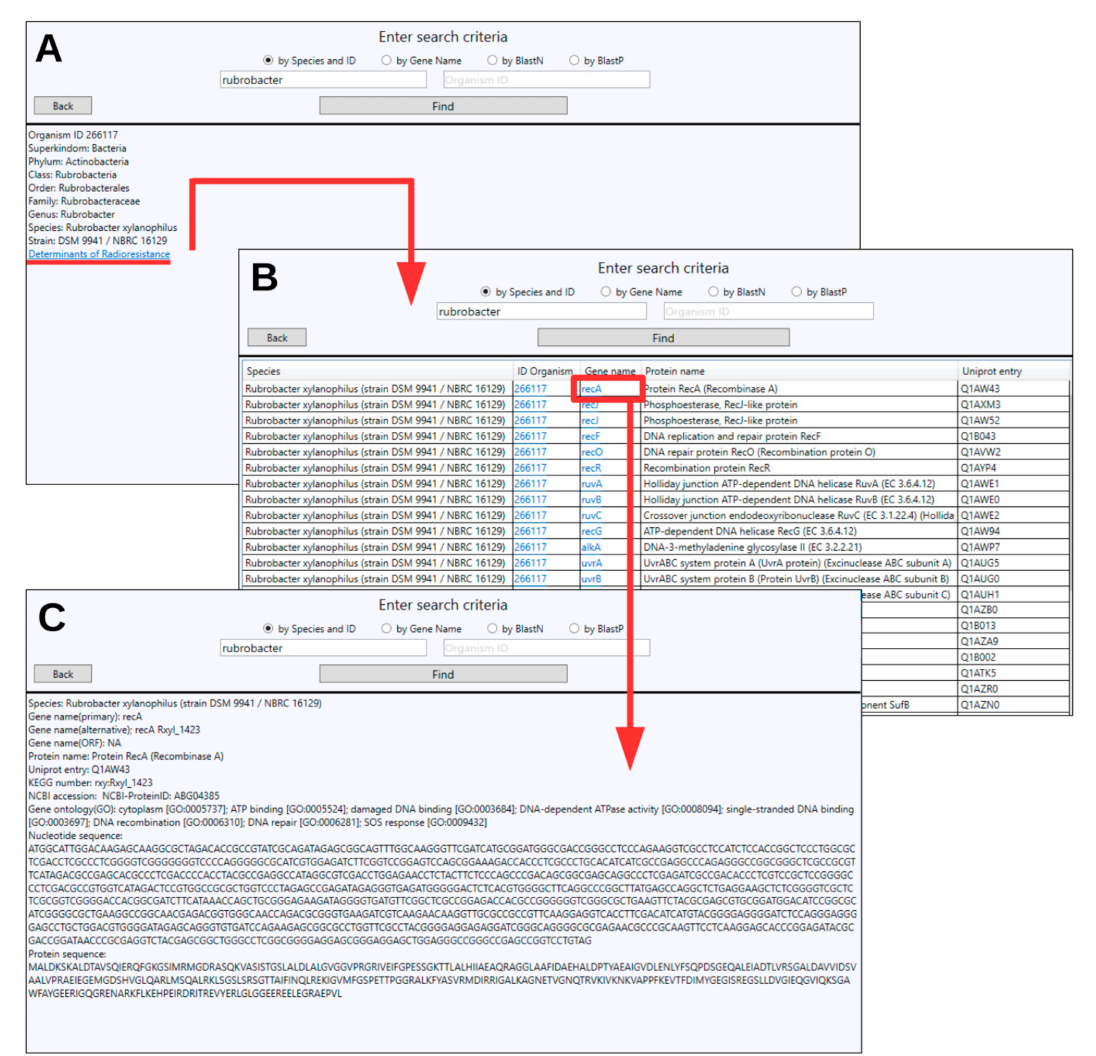
Figure 3. An example of search and navigation in the DetR DB. ( A ) The organism description page provides organism ID, taxonomy, and the link to the list of all determinants of ionizing radiation resistance for this species that are contained in the database. ( B ) The list of genes related to enhanced radioresistance of particular microorganisms, including common gene name, protein name, and UniProt entry number. ( C ) From the list of radioresistance determinants, the user can select a gene of interest and go to the page with its detailed